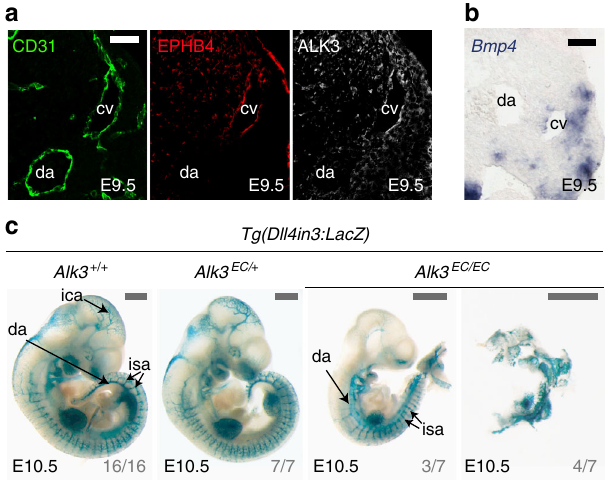
Fig. 9 Endothelial-speci fi c knockout of Alk3 results in loss of venous identity in mice. a , b . Immuno fl uorescent analysis of CD31, EPHB4 and ALK3 ( a ) and in situ hybridization for Bmp4 ( b ) in transverse sections from E9.5 mouse embryos. Scale bars are 50 μ m. c Representative E10.5 whole- mount images from wild-type Alk3 + / + ( n = 16), heterozygous Alk3 EC/ + ; ( n = 7) and homozygous Alk3 EC/EC ( n = 7) embryos expressing the arterial Dll4in3:LacZ transgene (Nine litters). Robust transgene expression, speci fi c to arterial endothelial cells, was seen in all embryos although Alk3 EC/EC embryos were often signi fi cantly growth retarded. Grey numbers on bottom right denote the number of embryos similar to picture shown; for Alk3 EC/EC , two different images show Dll4in3:LacZ expression in the range of morphological defects. Grey scale bars are 500 μ m. d Representative E10.5 whole-mount images from wild-type Alk3 + / + ( n = 34), heterozygous Alk3 EC/ + ; ( n = 21) and homozygous Alk3 EC/EC ( n = 16) embryos expressing venous Ephb4 LacZ (21 litters, for littermates, see Supplementary Fig. 16). Robust X-gal activity is detected in the veins of Alk3 + / + embryos but is reduced in Alk3 EC/ + embryos and absent in Alk3 EC/EC regardless of extend of growth retardation and morphological defects. Grey numbers on bottom right denote the number of embryos similar to picture shown; for Alk3 EC/EC , two different images are shown to indicate Ephb4 LacZ expression in the range of morphological defects. Grey scale bars are 500 μ m. e Representative transverse sections from E10.5 Alk3 EC/EC embryos transgenic for either arterial Dll4in3:LacZ or venous Ephb4 LacZ at two different levels. Some vessels were clearly seen in both; these expressed Dll4in3:lacZ but not Ephb4 LacZ and were located in arterial positions, suggesting the presence of dorsal aorta but no cardinal vein. Black scale bars are 100 μ m. f , g Representative arterial endothelial-speci fi c Alk3 + / + and Alk3 ART/ART whole-mount E10.5 embryos ( f ) and transverse sections stained with CD31 ( g ). Loss of Alk3 in arterial endothelial cells had no effect on vascular development at E10.5. White scale bars are 100 μ m. h Observed frequency of Alk3 fl / fl ;Dll4in3:Cre embryos at E10.5 and P5. Mendelian ratios were present at both time points. For all panels, EC is Tie2: Cre-mediated deletion, ART is Dll4in3:Cre-mediated deletion. + / + indicates Cre − , EC/ + indicates Cre + ,Alk3 fl / + and EC/EC indicates Cre + ;Alk3 fl / fl . da = dorsal aorta, ica = internal carotid artery, isa = intersomitic arteries, isv = intersomitic vessels, baa = branchial arch arteries, nt = neural tube, cv = cardinal vein, cev = branches of cerebral venous plexus, mda = midline dorsal